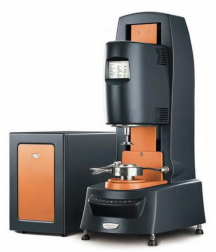
Figure 6. TA DHR-2